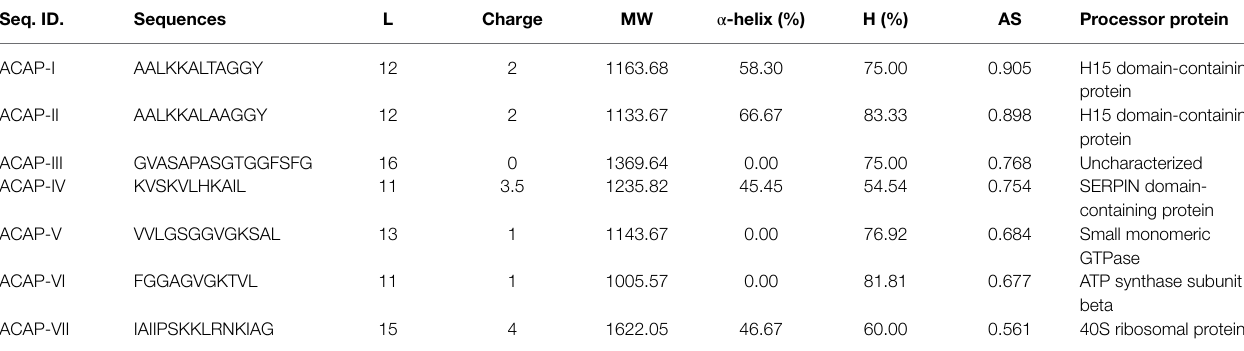
TABLE 2 | Physiochemical properties of most potent African Catfish Antimicrobial Peptides (ACAPs). Seq. ID.